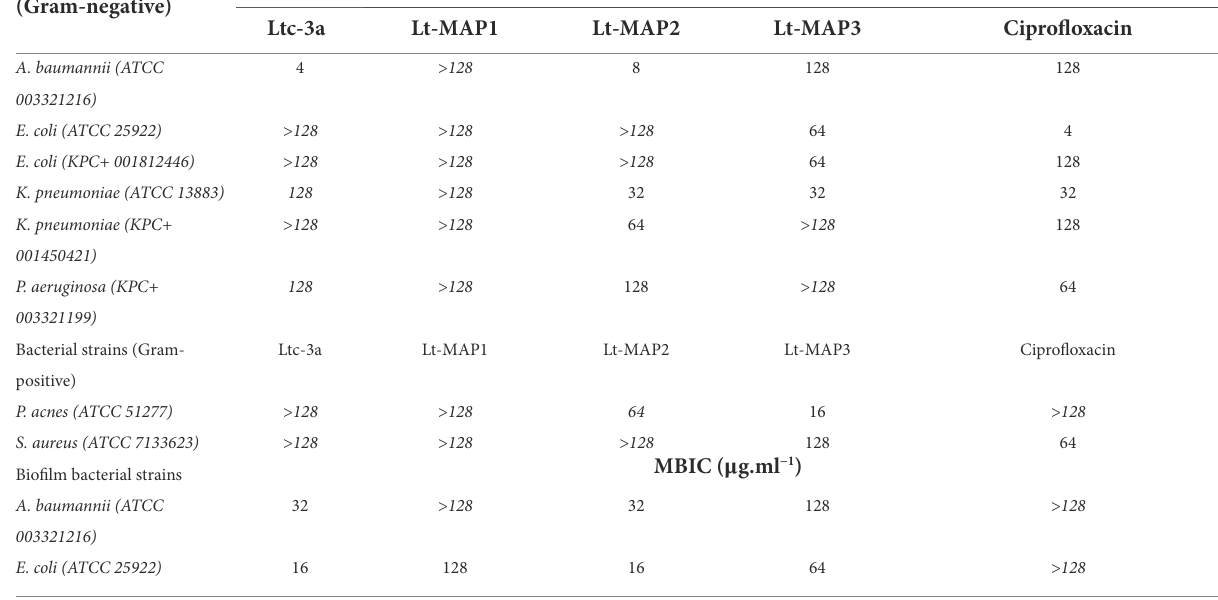
TABLE 2 Minimal inhibitory concentrations (MIC) and minimal biofilm inhibitory concentrations (MBIC) of latarcin-3a and its analogs Lt-MAPs, against Gram-negative and -positive bacteria strains. Bacterial strains